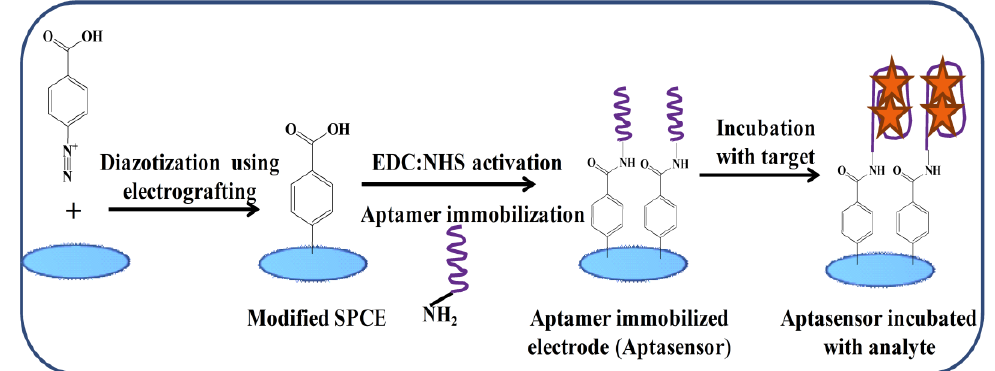
Figure 3. Schematic representation of an electrochemical aptasensor used for determination of AFB1 using diazotized SPCEs (scheme illustration from [81]).